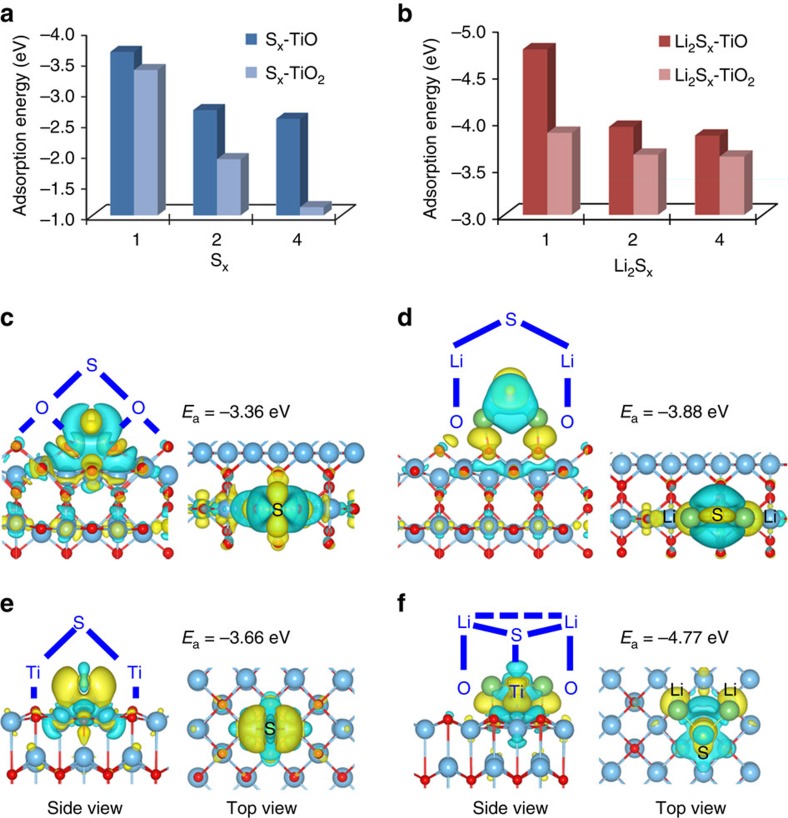
DFT analysis of adsorption energies of S species on TiO (001) and TiO2 (110).Adsorption energies for (a) Sx and (b) Li2Sx (x=1, 2 and 4) compounds on TiO (001) and TiO2 (110) surfaces. Isosurface of the charge density difference for (c) S and (d) Li2S adsorbed on TiO2 (110), and (e) S and (f) Li2S adsorbed on TiO (001). Yellow surfaces correspond to charge gains and blue surfaces correspond to an equivalent charge lost. To make the plot clear, the isovalues are defined as 0.002 in all cases.